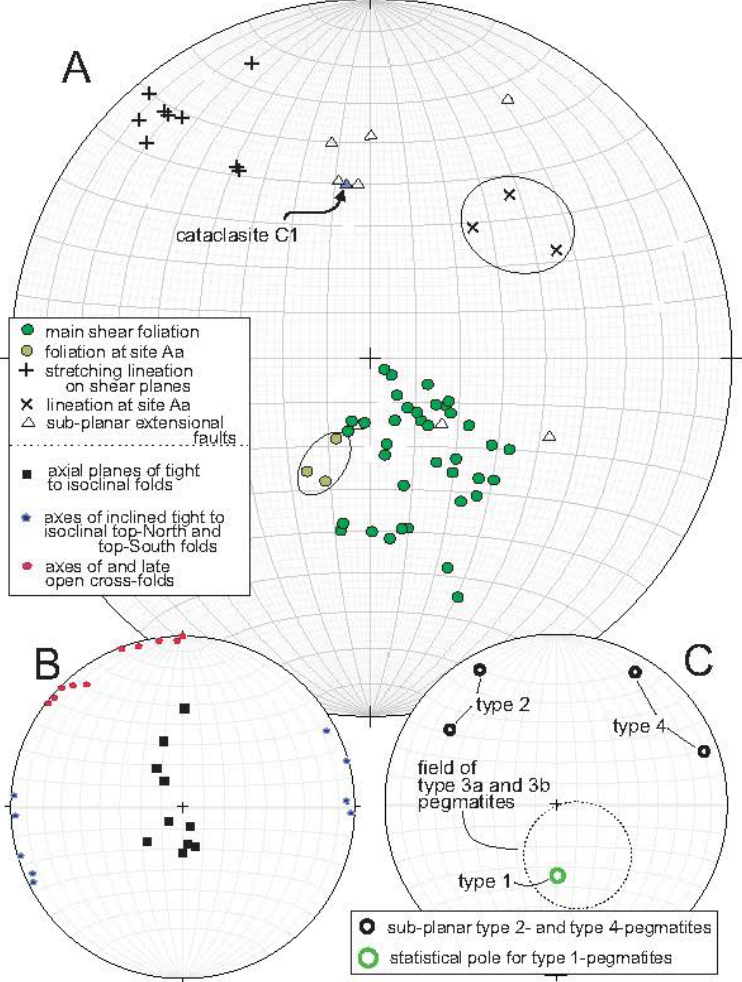
Figure 6. Stereoplots of structural data. (A) Foliations, stretching lineations and extensional fault planes (B) Fold axial planes and fold axes. ENE–WSW-trending fold axes represent recumbent folds associated with major shear. N–S-oriented fold axes represent late gentle to open cross-folds. (C) characteristic orientation of